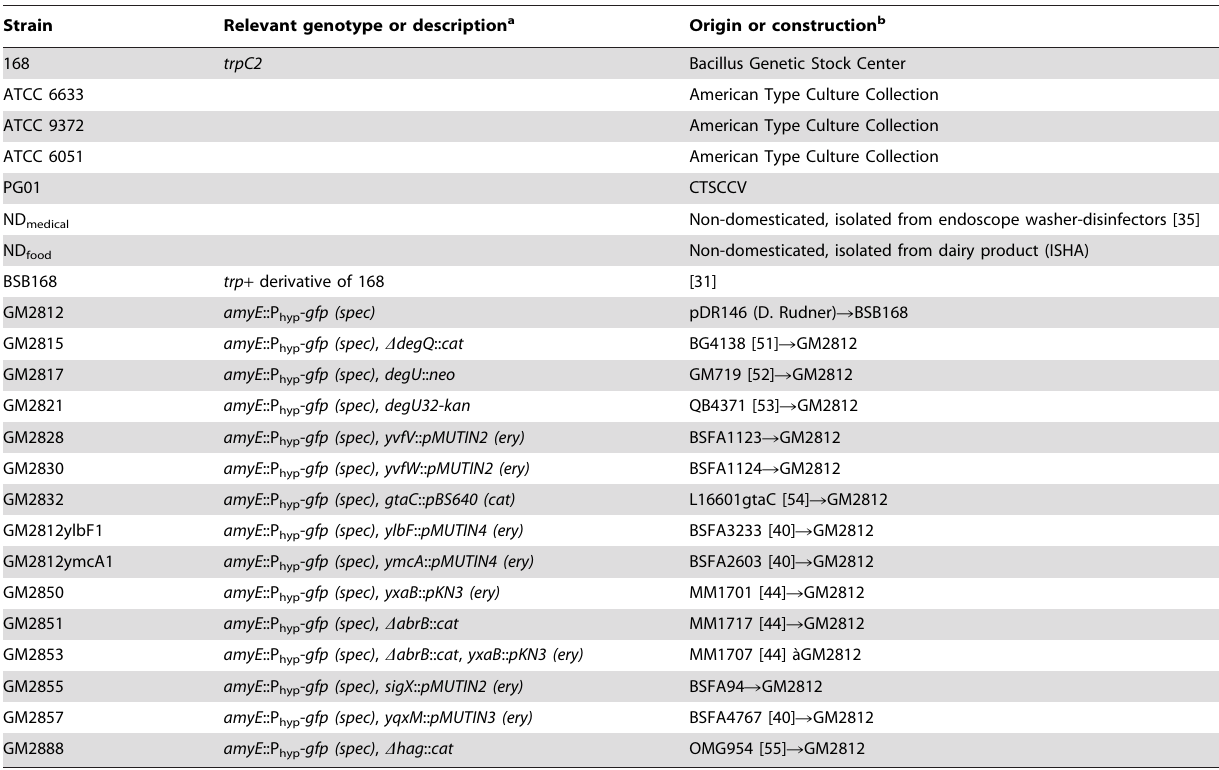
Table 1. Bacillus subtilis strains used in this